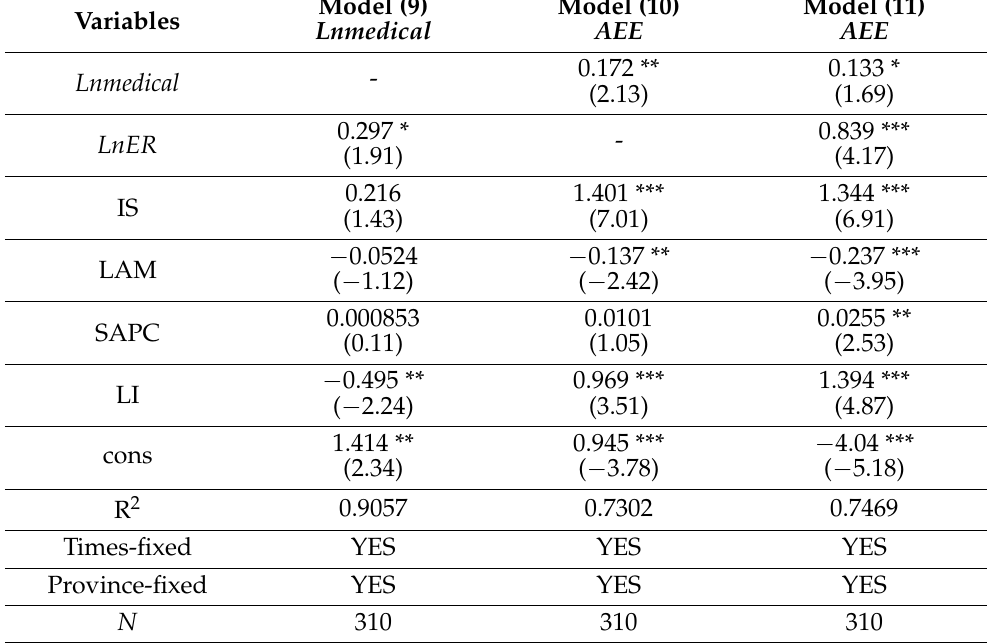
Table 5. Mediating effect test.